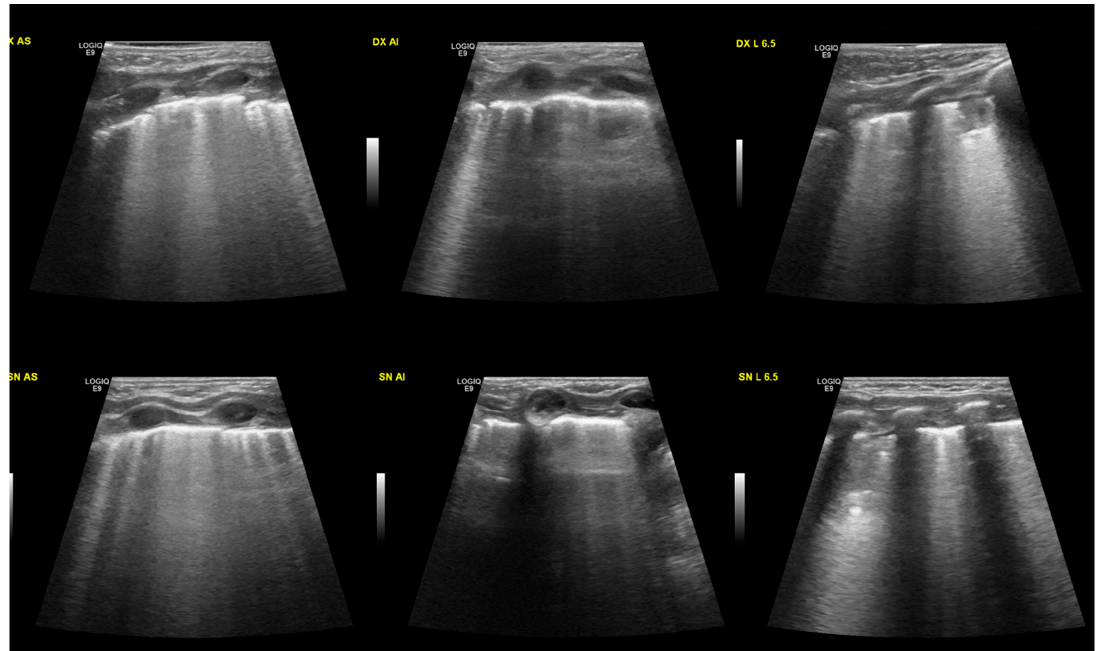
Figure 1. Typical ultrasound findings in MAS: B lines, often coalescing, and the pleural line is thickened and interrupted. Small consolidations (less than 1 cm) can be found in different areas of the lungs. At the top of the image, the right lung is shown, divided into three areas: the upper anterior, lower anterior, and lateral. In the lower portion of the image, the left